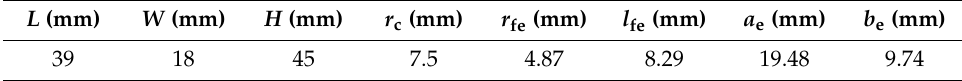
Table 1. Typical geometric parameters of particle flow channel and tubes.